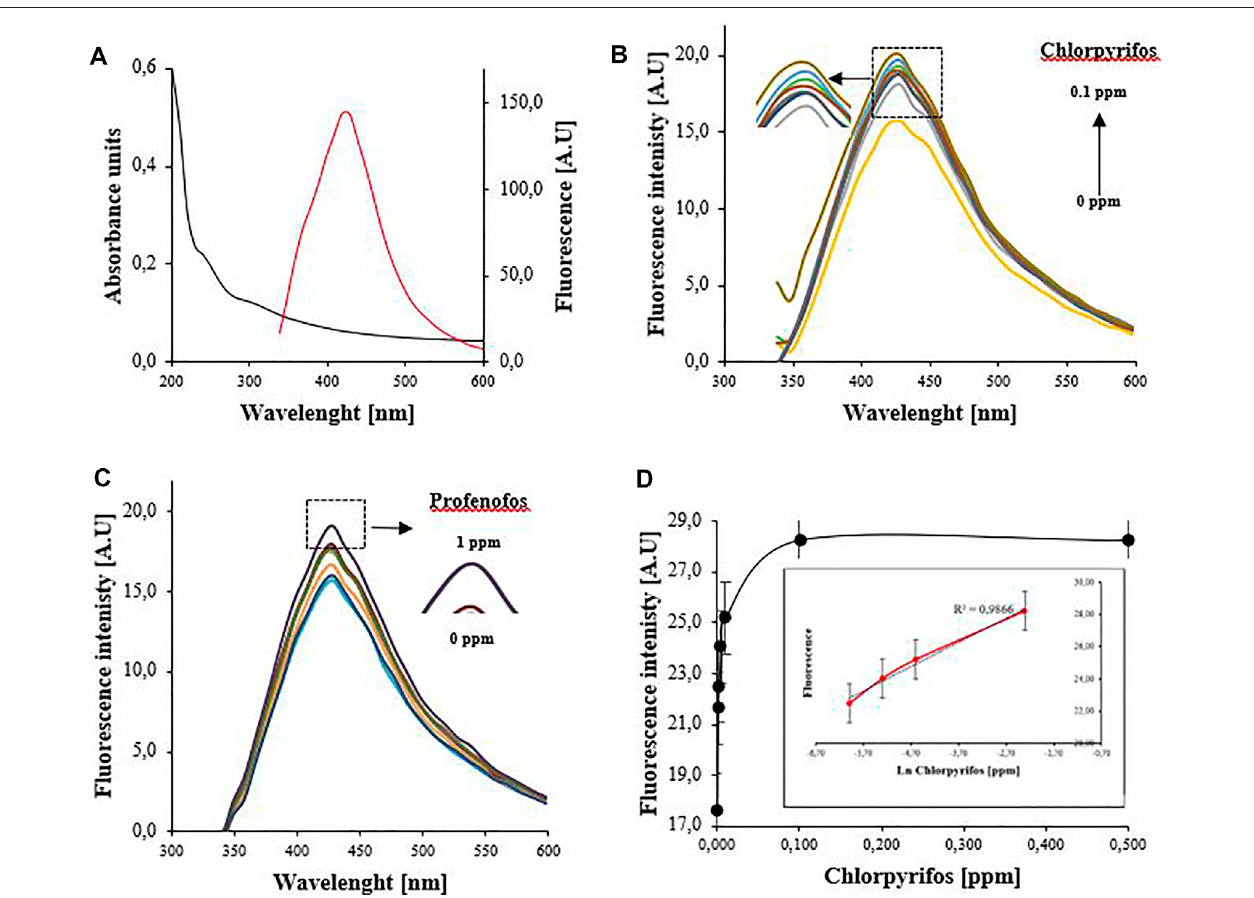
FIGURE 6 | (A) UV-Vis absorbance spectrum of the GO showing a partial overlapping with CD emission spectra at 320 nm (excitation wavelength). Emission spectra for (B) chlorpyrifos between 0 and 0.1 ppm and (C) profenofos between 0 and 1 ppm. (D) Exponential relationship between the fl uorescence intensity ( λ em = 420 nm) and the concentration of chlorpyrifos. Inset: Linear relationship between the fl uorescence intensity ( λ em = 420 nm) and the natural logarithmic value of chlorpyrifos concentration. Profenofos only shows detection at 1 ppm and does not show linear behavior in any